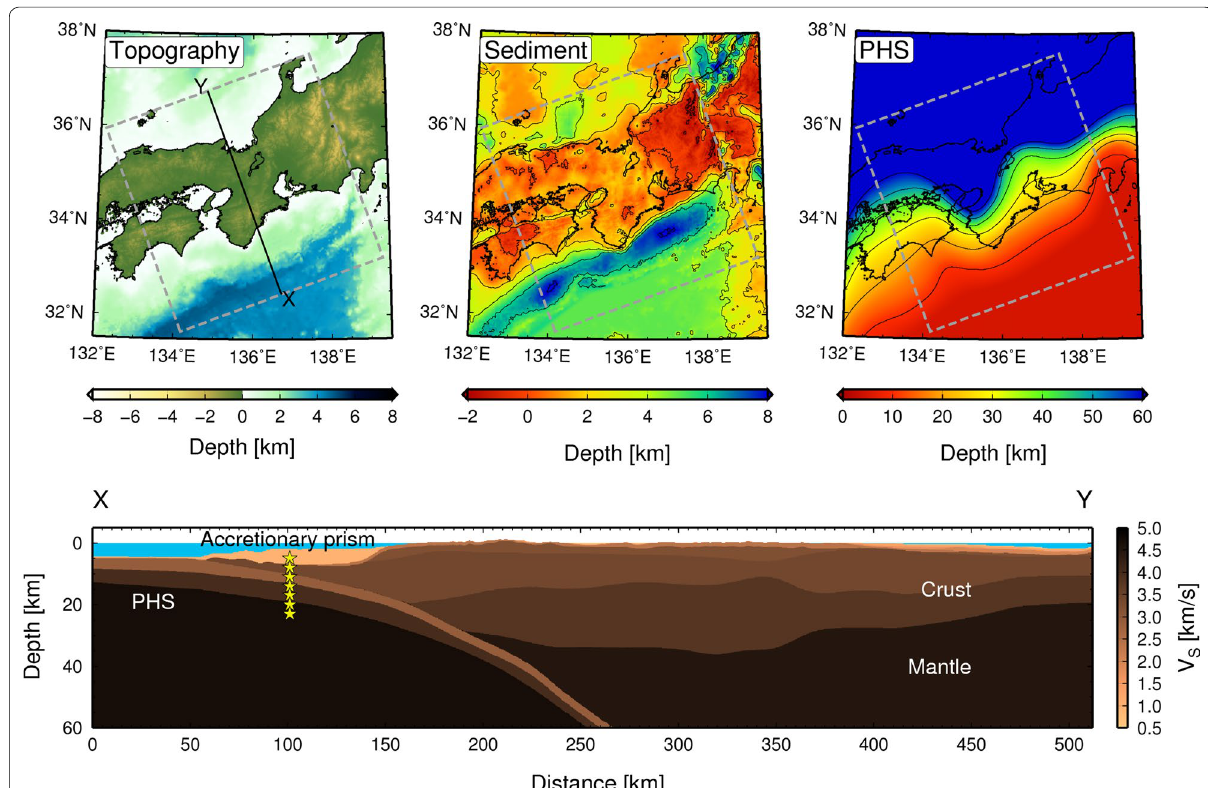
Fig. 3 Assumed seismic velocity structure model in the 3D simulations. Upper panels show depth variations of the topography, bedrock, and upper surface of the Philippine Sea slab (PHS). The dashed gray rectangle represents the horizontal coverage of the model for 3D simulations. Assumed S -wave velocity structure along the X – Y profile is shown in the bottom subfigure. Blue and white areas represent seawater ( V P V S 0.0 km/s, and ρ 1.0 g/cm 3 ) and air ( V P V S 0.0 km/s and ρ 0.001 g/cm 3 ) columns, = = = = =